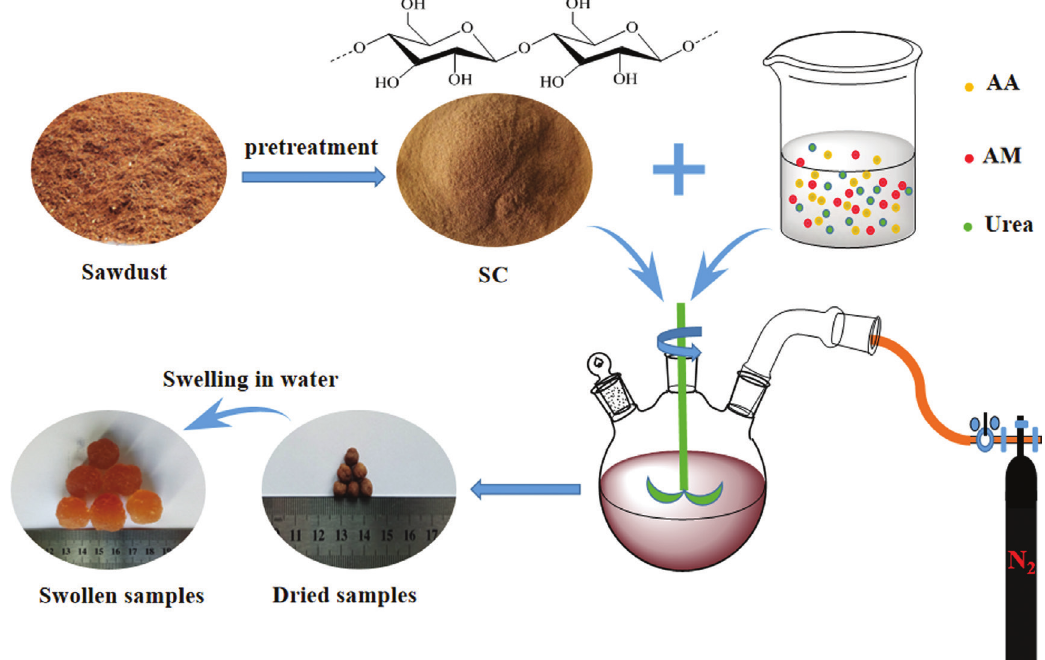
Scheme 2: Diagram of the fabrication process of